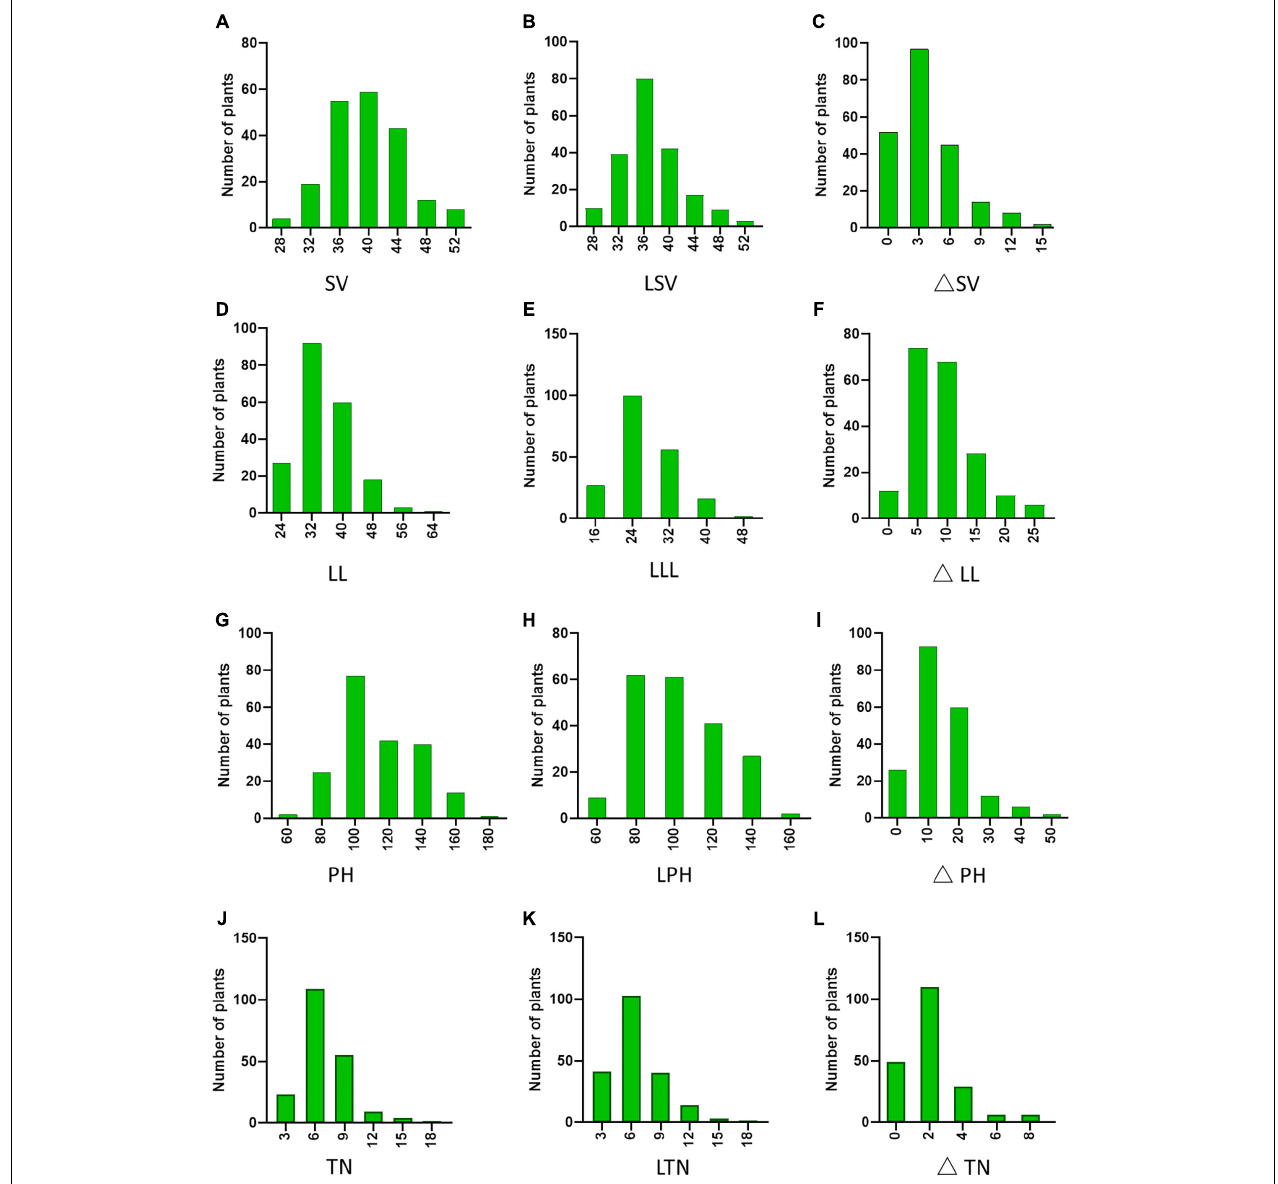
FIGURE 2 | Phenotypic diversity of 225 rice accessions: (A) SV, (D) LL, (G) PH, and (J) TN at NN level. (B) SV, (E) LL, (H) PH, and (K) TN at LN level. Phenotypic difference ( (cid:77) NN-LN) of (C) SV, (F) LL, (I) PH, and (L) TN.